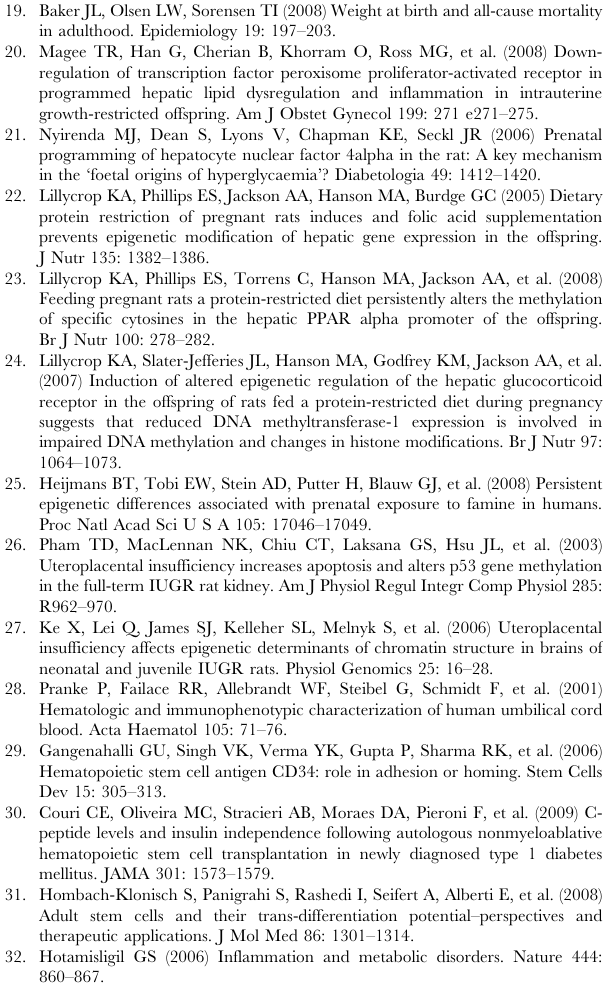
Table S2 Characteristics of top 56 candidate loci identified by HELP. All positions correspond to coordinates in the human genome, hg18 March 2006 UCSC Genome Browser; IUGR